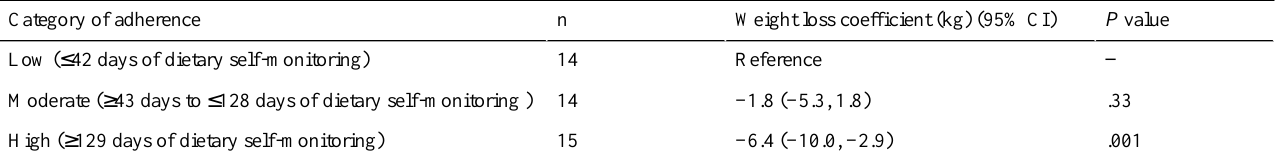
Table 3. Regression analysis of category of My Meal Mate use as a predictor of follow-up weight (adjusted for baseline weight) in the My Meal Mate arm of the pilot